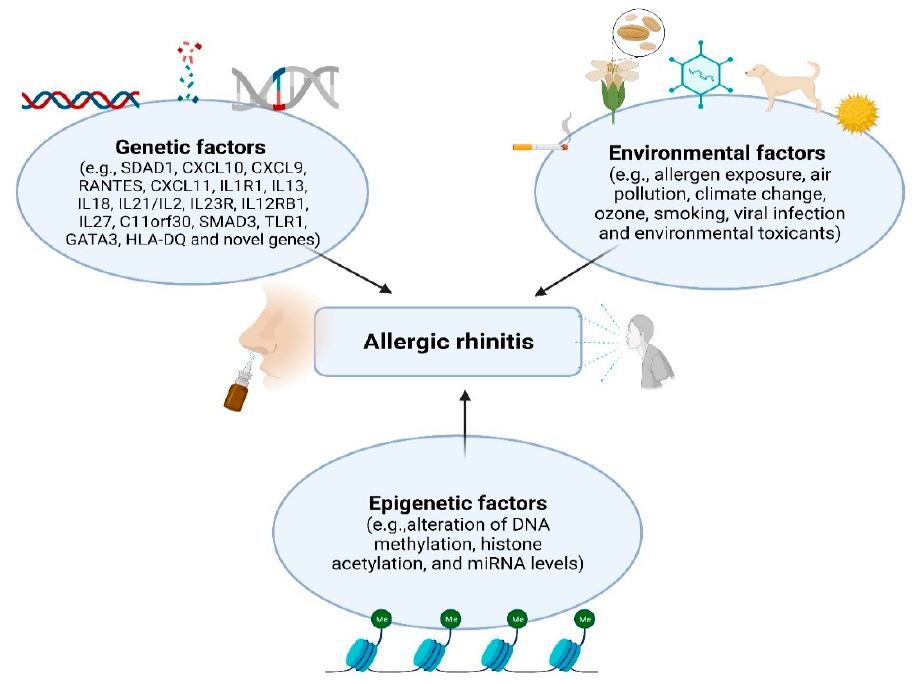
Figure 1. Environmental/genetic/epigenetic factors in AR (Figure was created with Biorender.com, accessed on 13 December 2021).